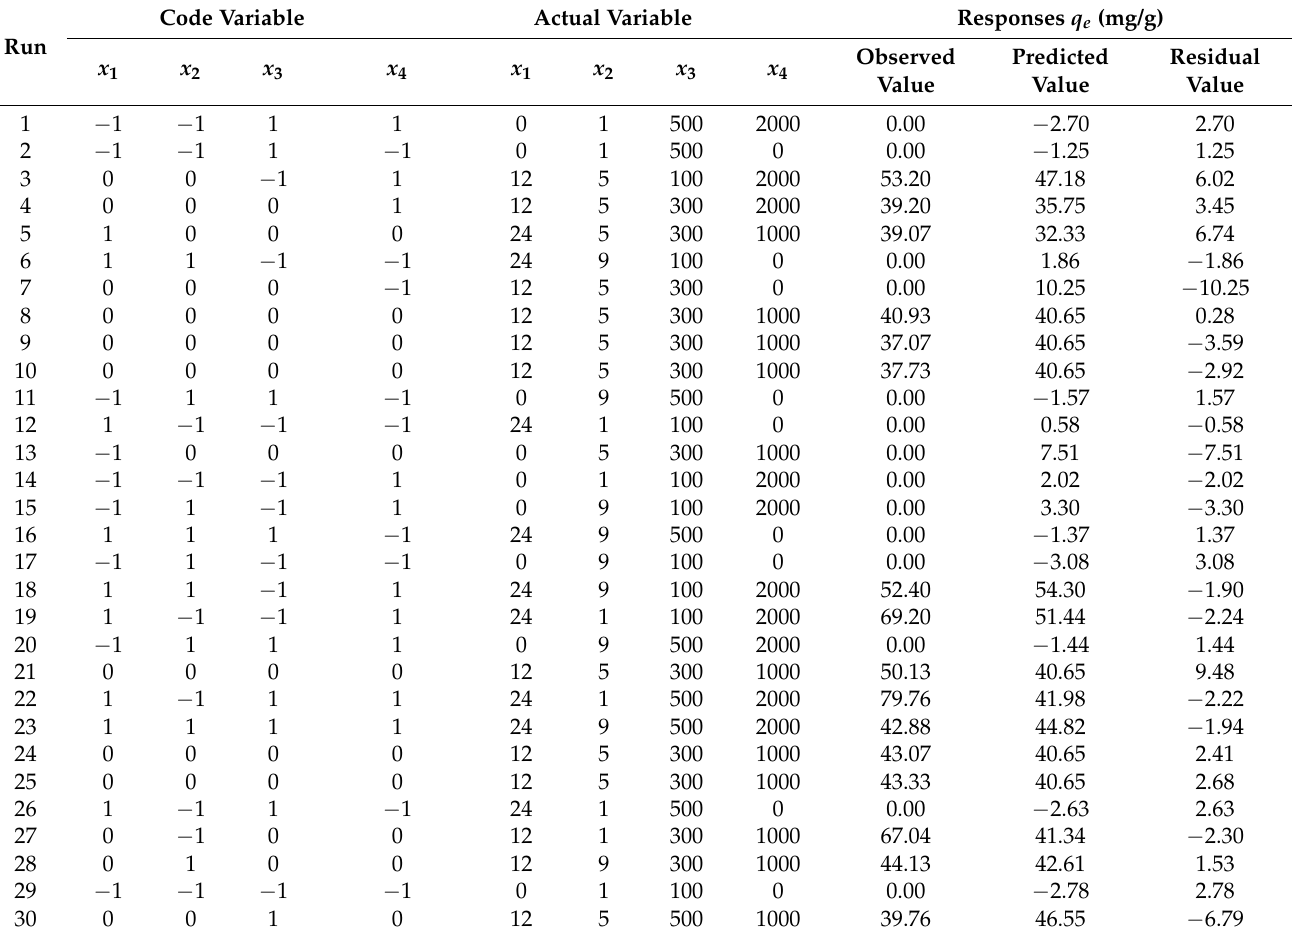
Table 5. Code and actual variable factors related to observed and predicted responses of Cu(II) loaded onto selected H + Dowex-M4195 chelating resin.